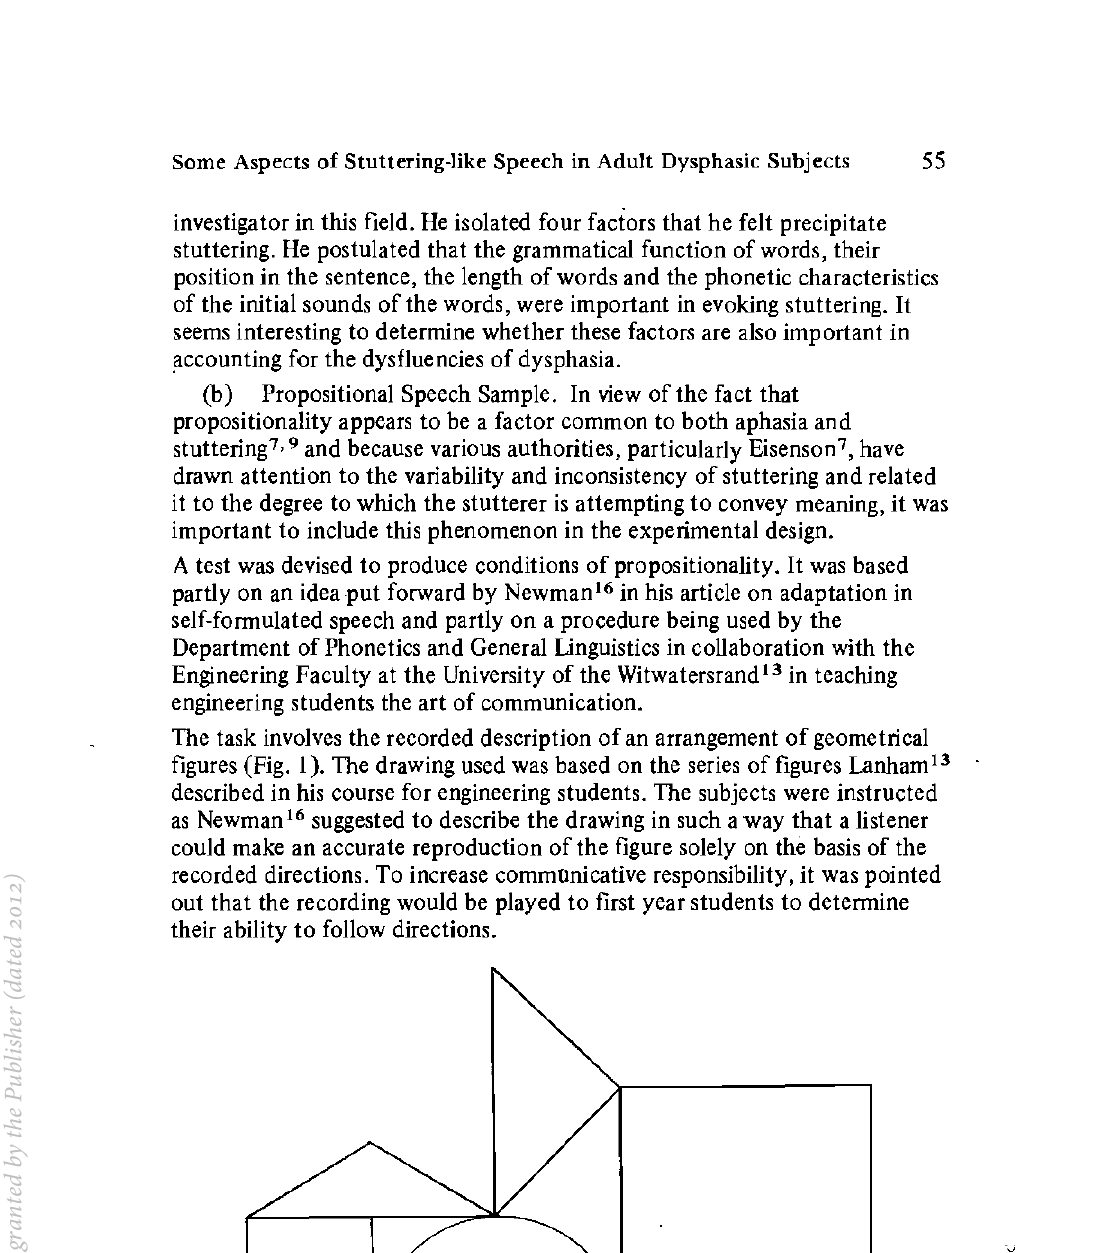
Figure 1. Diagram used to Elicit a Propositional Speech Sample. Tydskrif van die Suid-Afrikaanse Vereniging vir Spraak- en Gehoorheelkunde Vol. 19, Desember